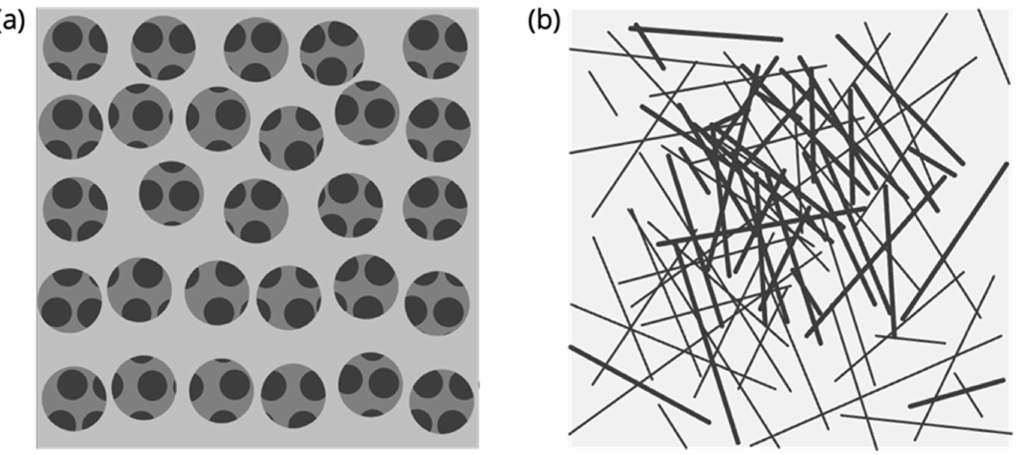
Figure 12. Structural differences between a porous material ( a ) and a fibrous material ( b